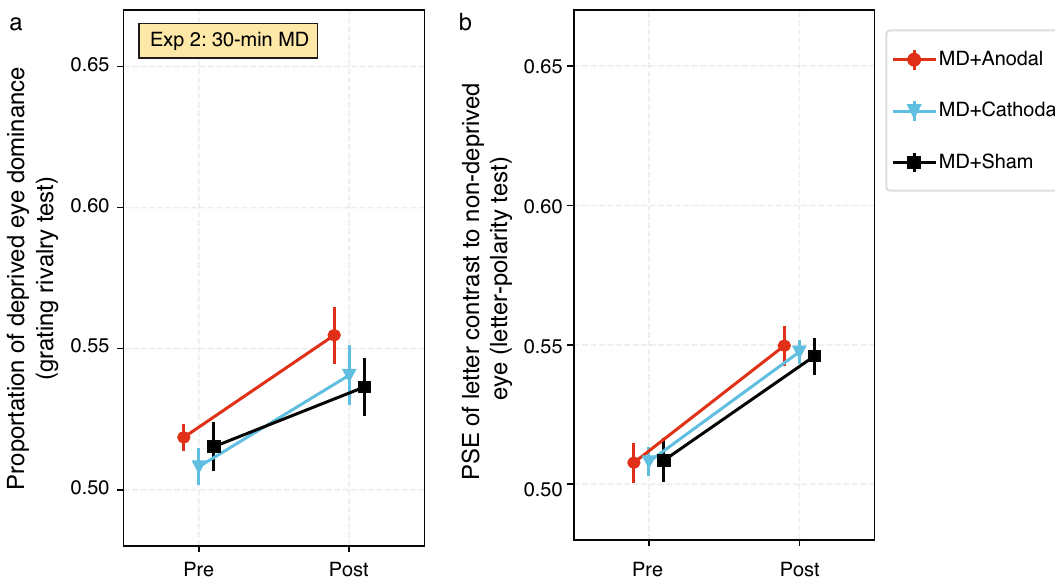
Figure 3. Deprived eye dominance data at different time points under each condition in Experiment 2. ( a ) Grating rivalry test. ( b ) Letter-polarity test. Ocular dominance was measured at baseline (Pre) and immediately after MD (Post). Error bars represent standard errors of the mean. Note that these plots share the same y-axis scale as Fig. 2 to facilitate Secondary outcome: mixed percepts and alternation rate. Supplementary Fig. S3 shows the changes in the durations of superimposition, piecemeal and overall mixed percepts. As in Experiment 1, none of these per- cepts changed significantly after MD (superimposition: χ 2 = 1.146, p = 0.284, W = 0.034; piecemeal: F 1,8 = 1.939, p = 0.201, ω 2 = 0.004; overall mixed: F 1,8 = 4.107, p = 0.077, ω 2 = 0.020). In addition, tDCS did not modulate any of these percepts (superimposition: χ 2 = 1.244, p = 0.537, W = 0.040; piecemeal: F 2,16 = 0.554, p = 0.585, ω 2 < 0.001; overall mixed: F 2,16 = 0.704, p = 0.509, ω 2 < 0.001). No interaction was found between Time and Condition for piecemeal ( F 2,16 = 0.397, p = 0.679, ω 2 < 0.001) or for overall mixed percept ( F 2,16 = 0.480, p = 0.628, ω 2 < 0.001). Supplementary Fig. S4 shows changes in alternation rate as measured by the grating rivalry test. Alternation rate did not change significantly after MD (Time: F 1,8 = 0.562, p = 0.475, ω 2 < 0.001). tDCS had no effect on alterna- tion rate (Condition: F 2,16 = 0.869, p = 0.438, ω 2 < 0.001). There was no interaction between Time and Condition ( F 2,16 = 0.718, p = 0.503, ω 2 < 0.001). Comparison between Experiments 1 and 2: effect of MD duration on ocular dominance plas‑ ticity.